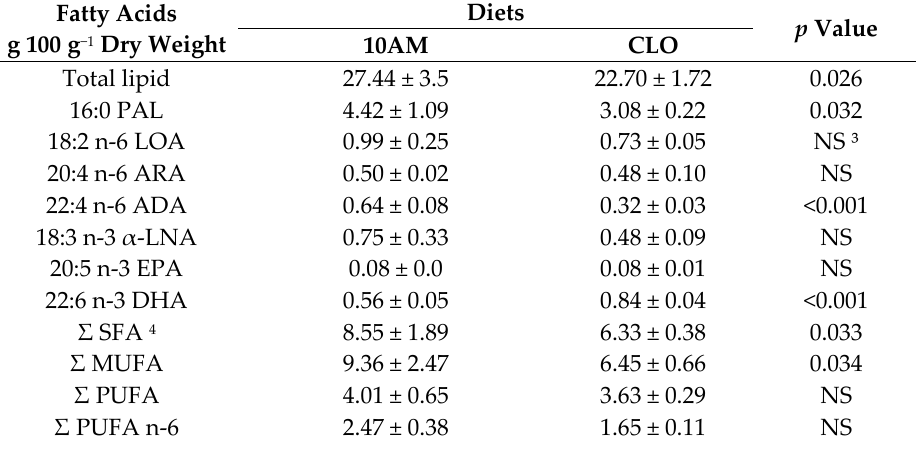
Table 7. Total lipid and fatty acid composition of hepatopancreas in Nile tilapia juveniles fed with two sources of DHA for 87 days, at 22 °C 1,2